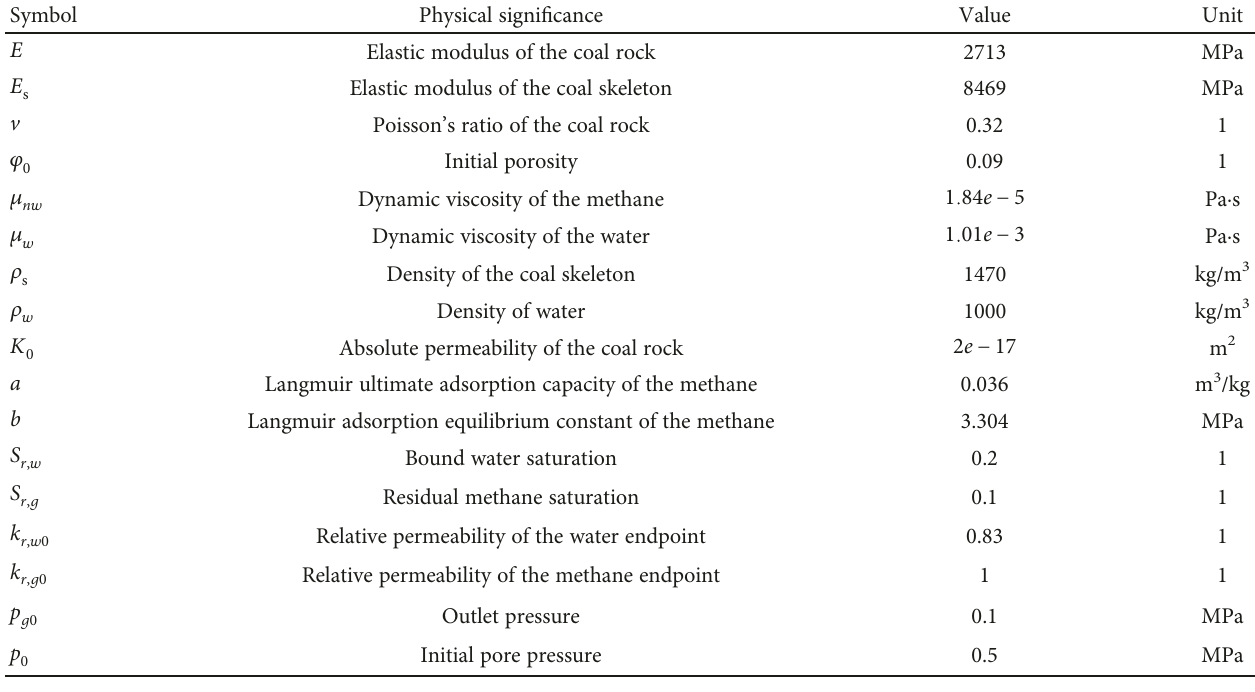
Table 1: Parameters of the numerical simulation.